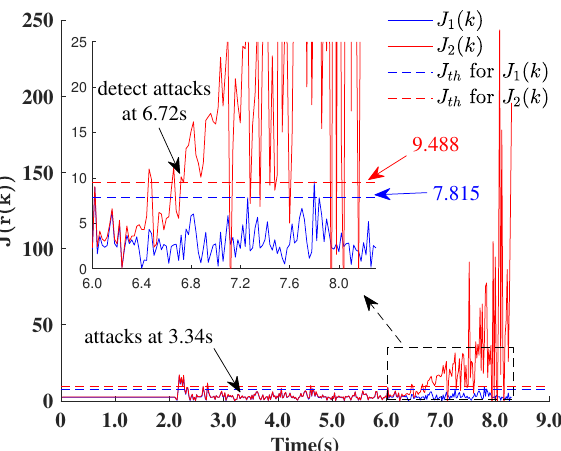
Figure 7. The detection results of zero-dynamic attacks based on r 0 ( k ) and r β ( k ) . Moreover, as seen in Figure 4, the injection of zero-dynamic attacks in the early stage does not have a great impact on the normal operation of the OMR, and its main function in this stage is to take over the actuators stealthily in preparation for the subsequent major attacks on the system. Therefore, it is of practical significance for the method based on r β ( k ) to detect the zero-dynamic attacks before they have a large impact on the system. For the detection of covert attacks, in Figure 8, we can find that, after injecting covert attacks, the detection method based on r 0 ( k ) does not detect the existence of the attacks at all. In contrast, the detection method based on r β ( k ) can detect the attacks obviously and can detect the attacks continuously with the existence time of the attacks, which will make the covert attacks invisible.